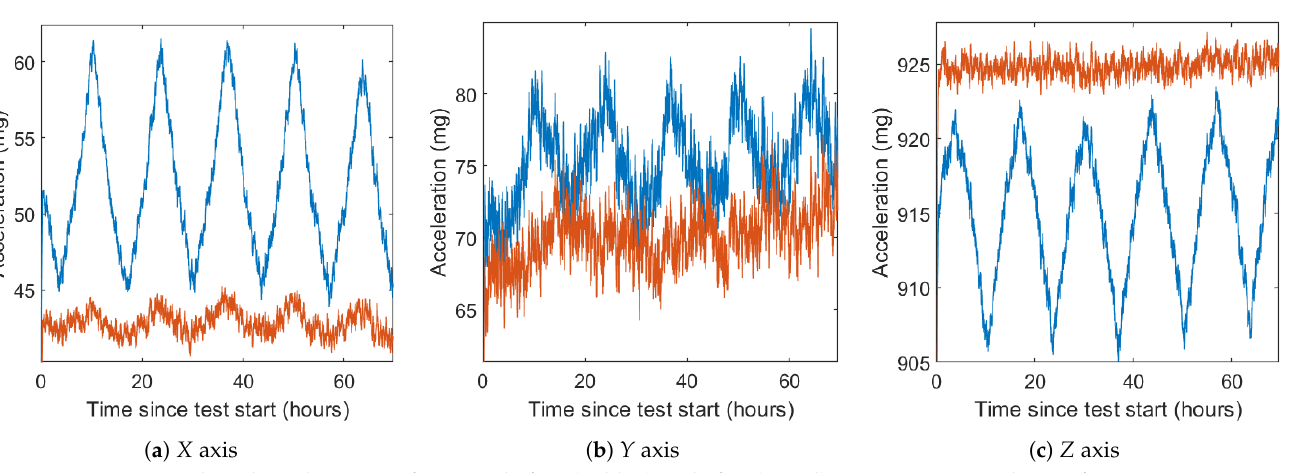
Figure 12. Filtered accelerations of DUT #1 before (in blue) and after (in red) compensation in the verification test.